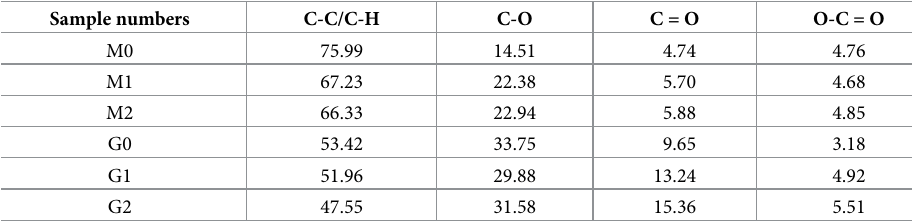
Table 5. Relative content of organic carbon in different